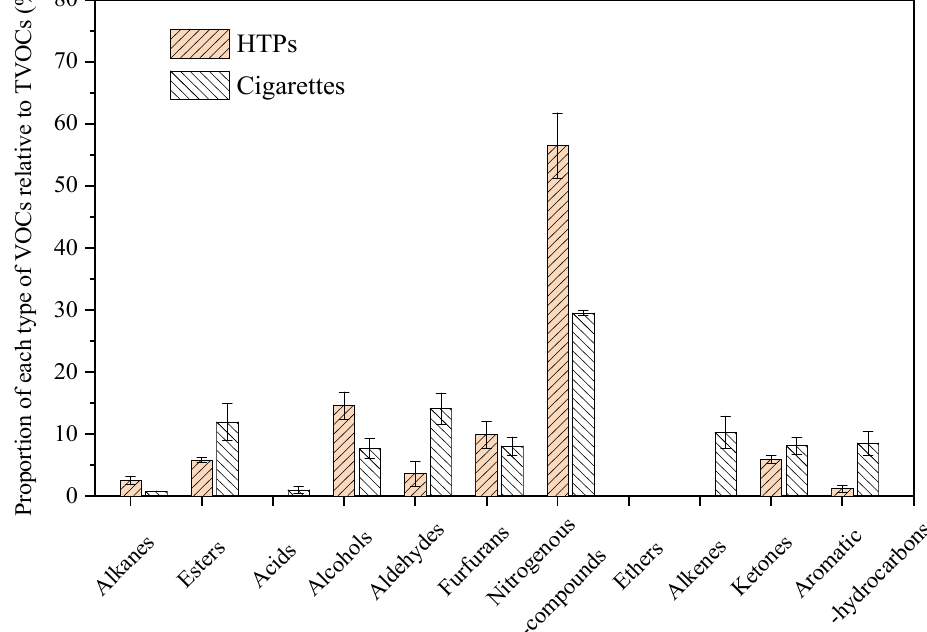
Figure 4. Proportion of each type of VOC relative to the TVOCs emitted by the heating method and burning method. burning